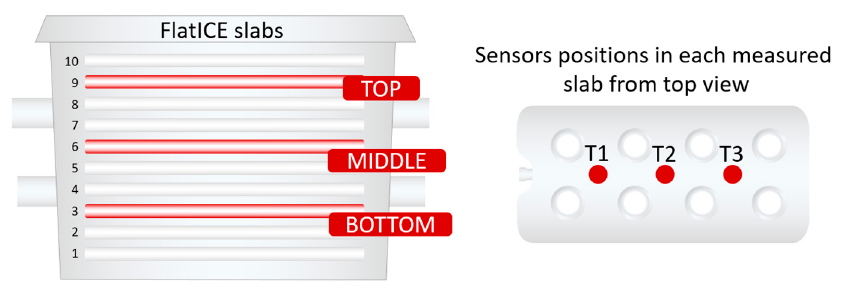
Figure 4. Location of temperature sensors inside the storage unit.